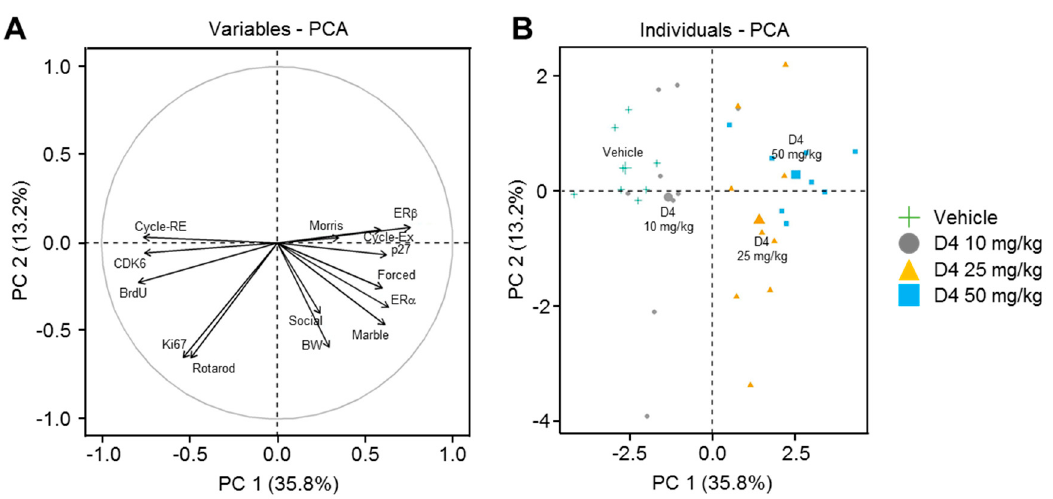
Figure 7. Multivariate principal component analysis (PCA) showing the effects of prenatal exposure to D4 on brain development. ( A ) The correlation circle. ( B ) The scatter plot. Cycle RE = cell cycle re-entry, Cycle Ex = cell cycle exit, ER alpha = ERa, ER beta = ERb, Morris = Morris water maze test, Forced = forced swimming test, Marble = marble burying test, BW = brain weight, Social = social novelty test, Rotarod = rotarod test.